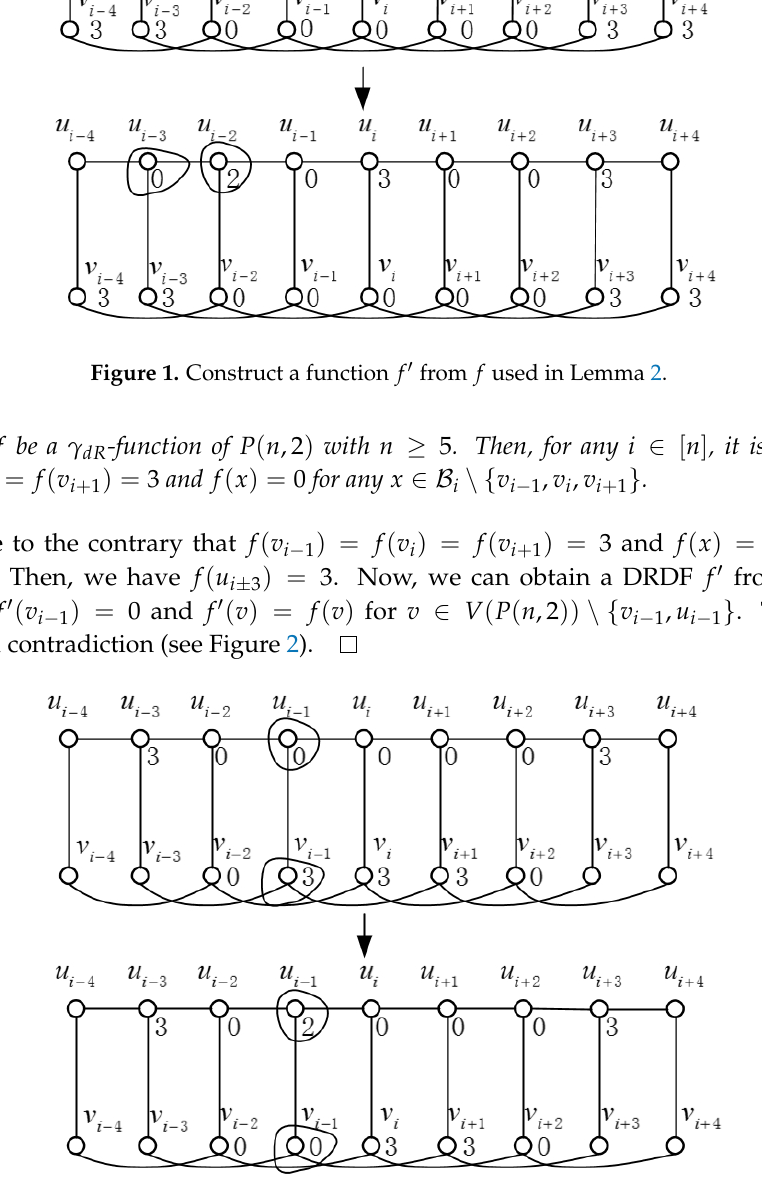
Figure 2. Construct a function f (cid:48) from f in Lemma